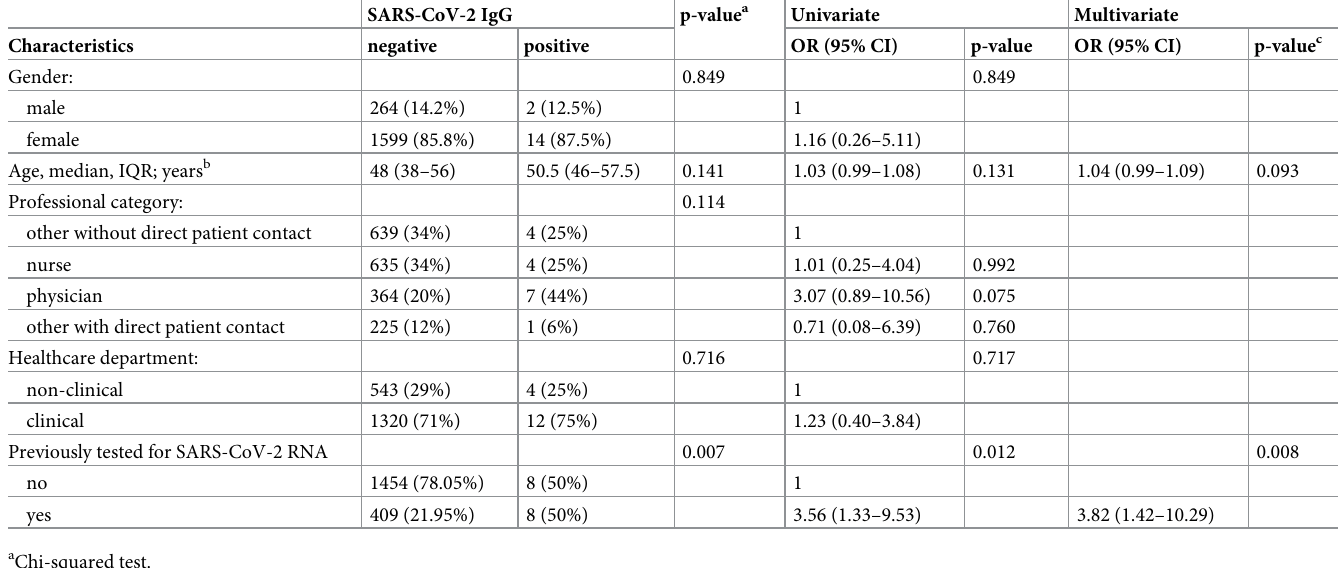
Table 3. Analysis of factors associated with SARS-CoV-2 IgG positivity.